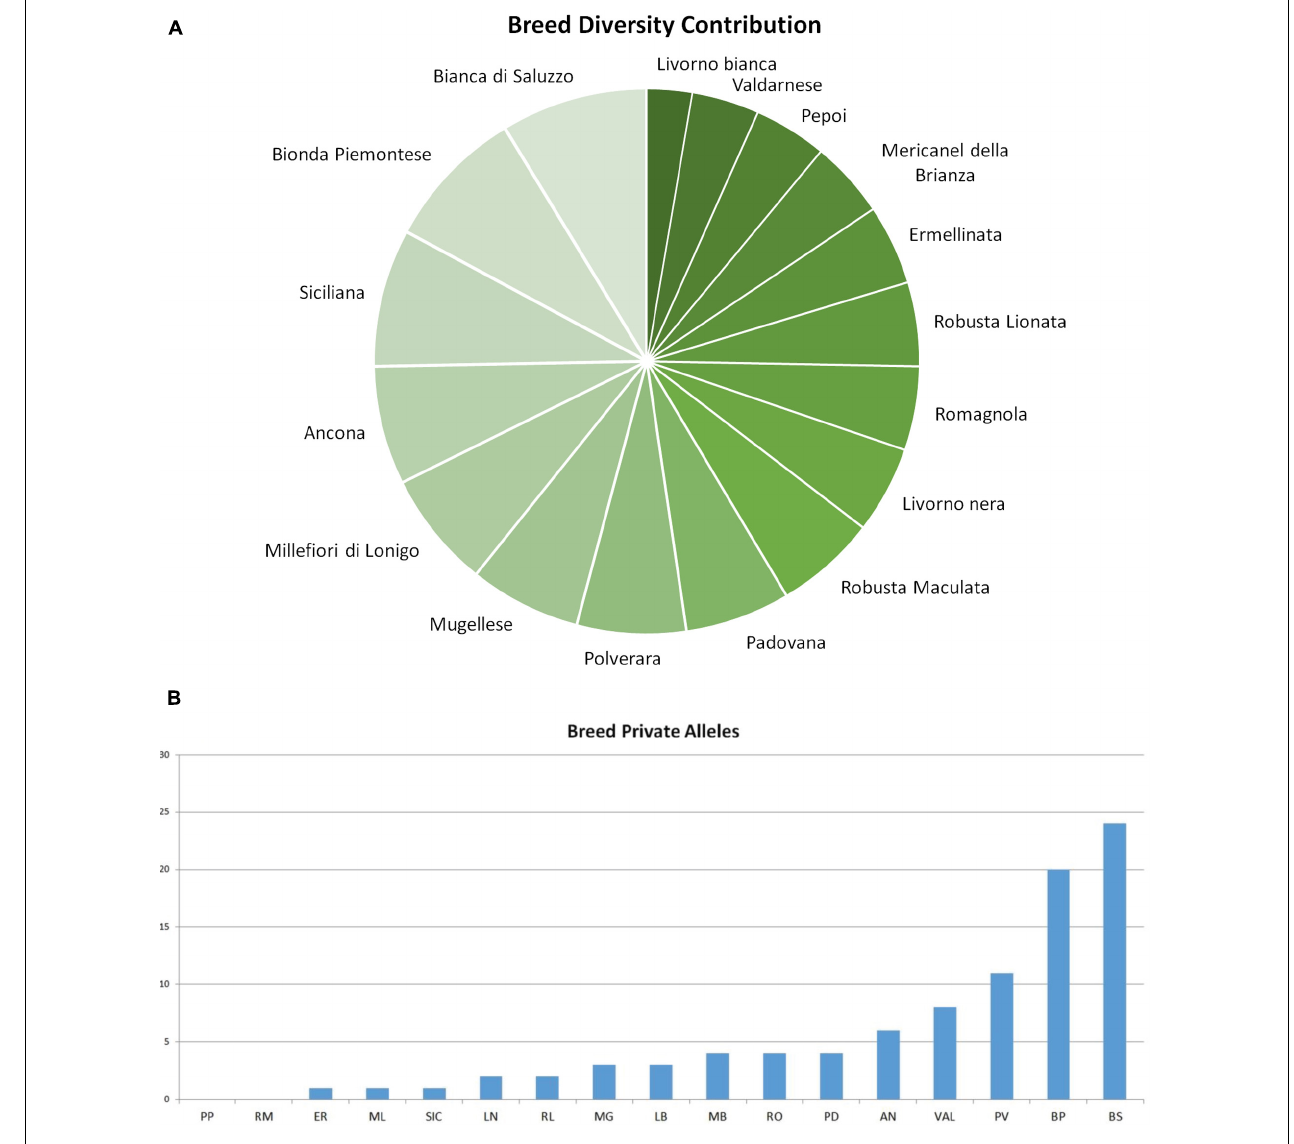
FIGURE 3 | Graphical output of breed diversity contribution. (A) Breed contribution to overall genetic diversity. (B) Breed private alleles: bar graph of private allele number detected in each breed. AN, Ancona; BP, Bionda Piemontese; BS, Bianca di Saluzzo; ER, Ermellinata di Rovigo; LB, Livorno Bianca; LN, Livorno Nera; MB, Mericanel della Brianza; ML, Millefiori di Lonigo; MG, Mugellese; PD, Padovana; PP, Pepoi; PV, Polverara; RL, Robusta Lionata; RM, Robusta Maculata; SI, Siciliana; VA, Valdarnese; and RO,